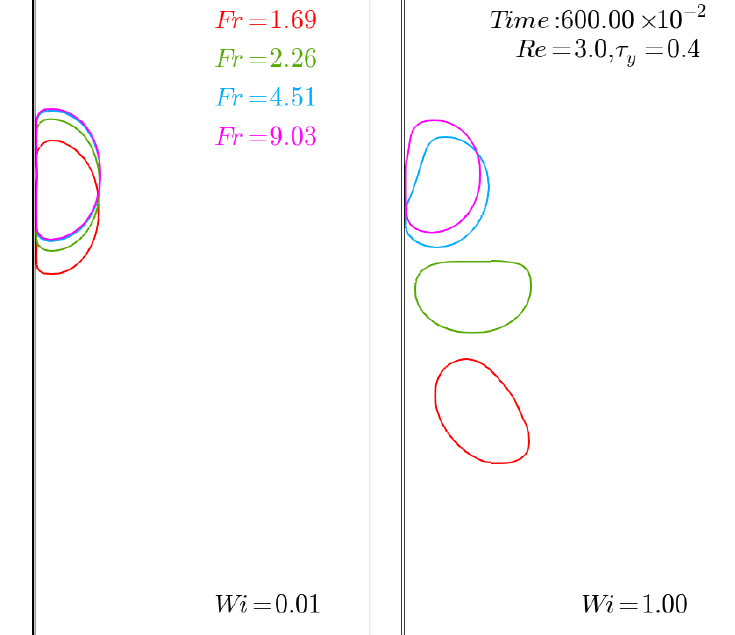
Figure 6. Collision of drops on a vertical wall for fixed values of the Reynolds, Re = 3, and plastic numbers, τ y = 0.4 and the following values of the Froude number, Fr = { 1.69;2.26;4.51;9.03 } . ( left column ) Wi = 0.01; ( right column ) Wi = 1.0. Dimensionless time, t =